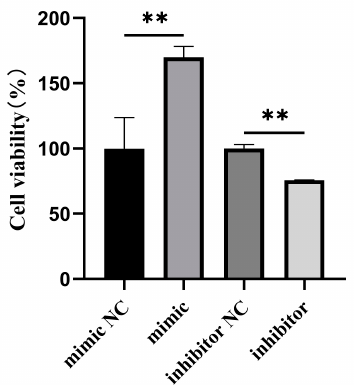
Figure 4. Effect of bta-miR-199a-3p on LPS-induced proliferation of MAC-T cells. The LPS-induced MAC-T cells’ viability was analyzed using the CCK-8 method after transfection with the bta-miR- 199a-3p mimic or inhibitor, and the final data were normalized. ** refers to p < 0.01.